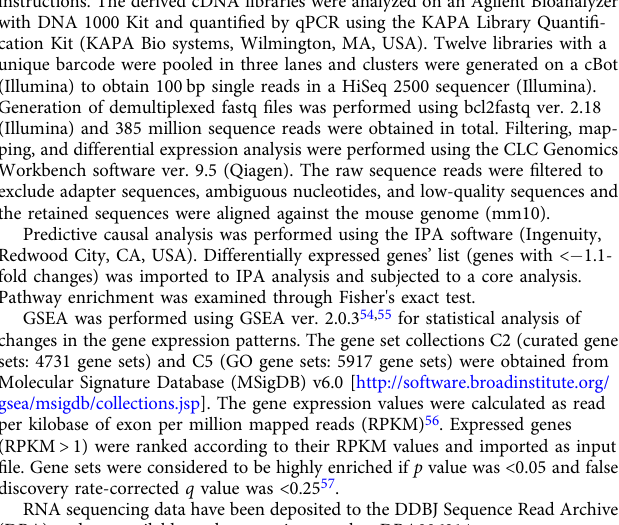
Administration of Dox . TRE promoter-dependent transgene expression was regulated using the animal ’ s (dnBMAL1 and WT mice) drinking water